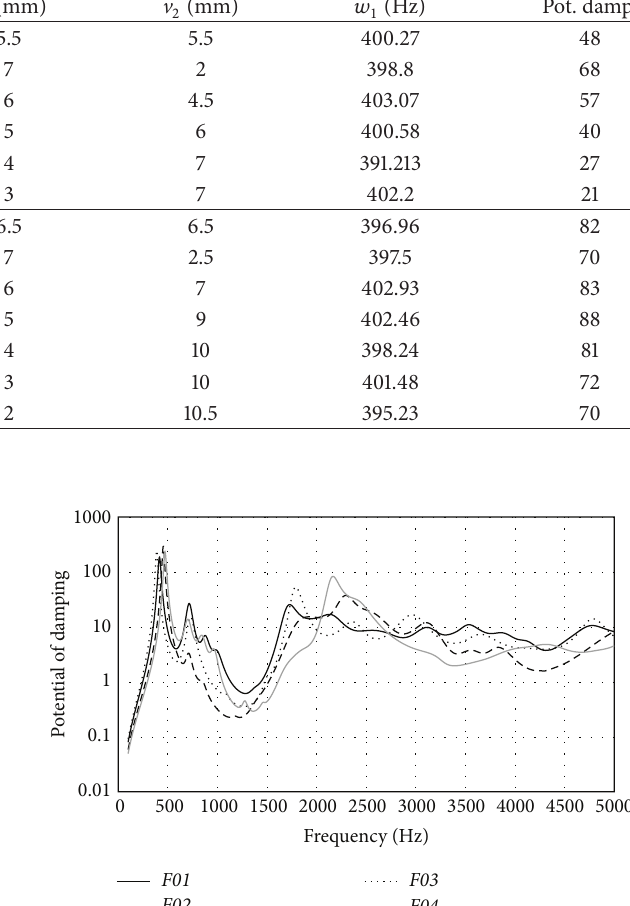
Table 10: Simulated two-layer sandwich-type CLD designing geometric parameters and simulation results. 𝑚 0 = 3 mm. Designing geometric parameters Results Design